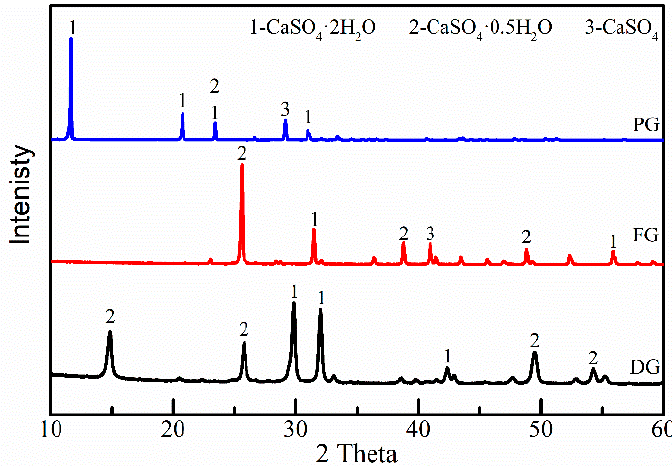
Figure 2. XRD patterns of different gypsums. Figure 2. XRD pa tt erns of di ff erent gypsums. Figure 2. XRD pa tt erns of di ff erent gypsums.